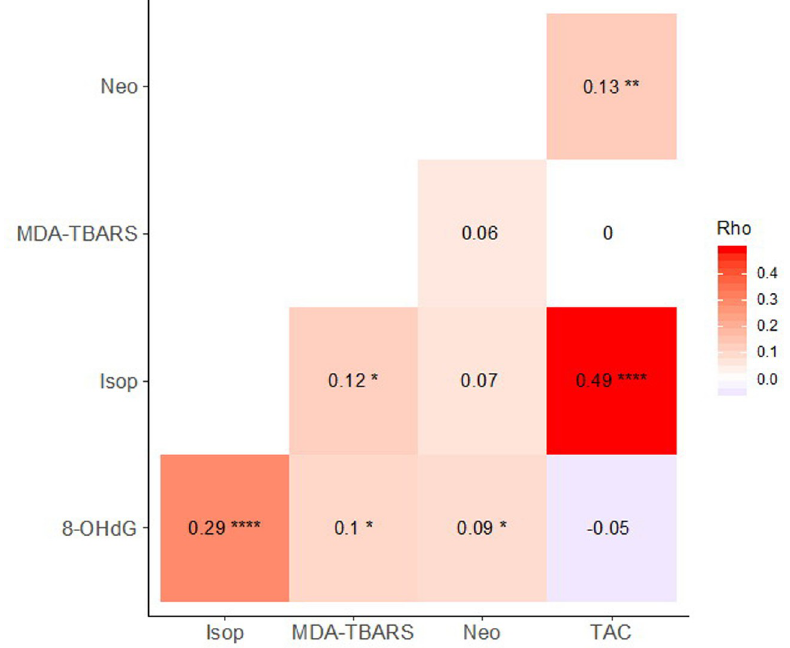
Fig 1. Correlations between OS biomarkers. Spearman’s rho written in heat tiles, with significant correlations indicated as ���� p < 0.0001, ��� p < 0.001, �� p < 0.01, � p < 0.05, and † p < 0.10.